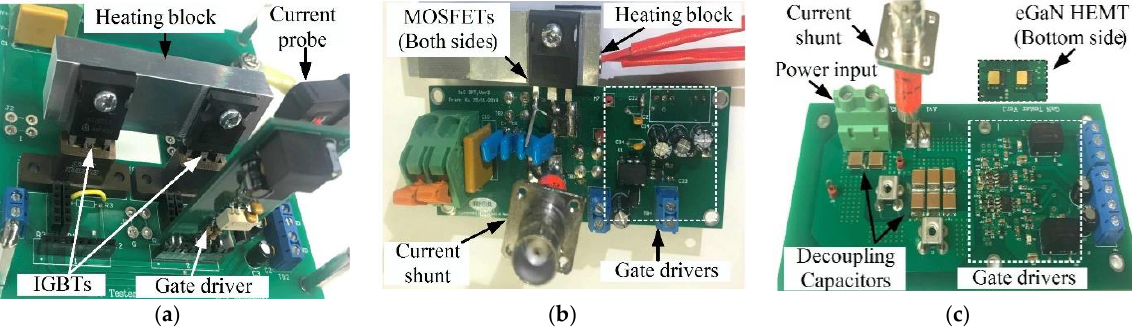
Figure 9. Device characterization DPT setups for ( a ) Si IGBT/MOSFET; ( b ) SiC MOSFET; ( c ) eGaN HEMT. Table 4. Calibration time of probes and waveforms.